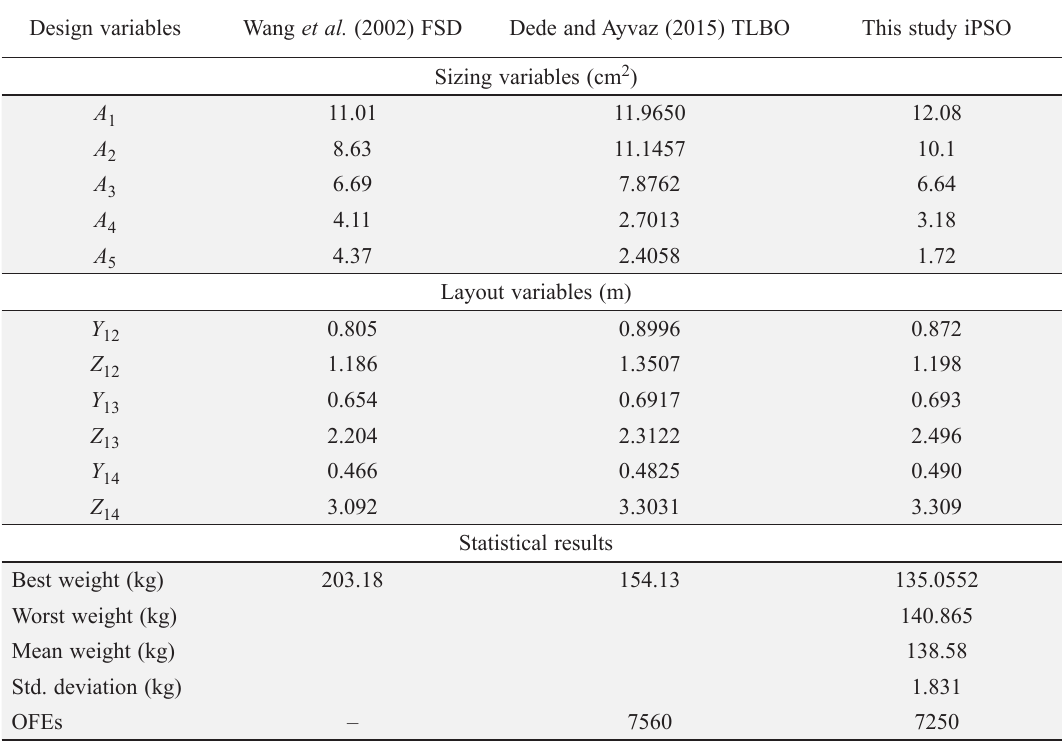
Table 10. Comparison of the iPSO optimization results with the literature for the spatial 39-bar truss problem Design variables